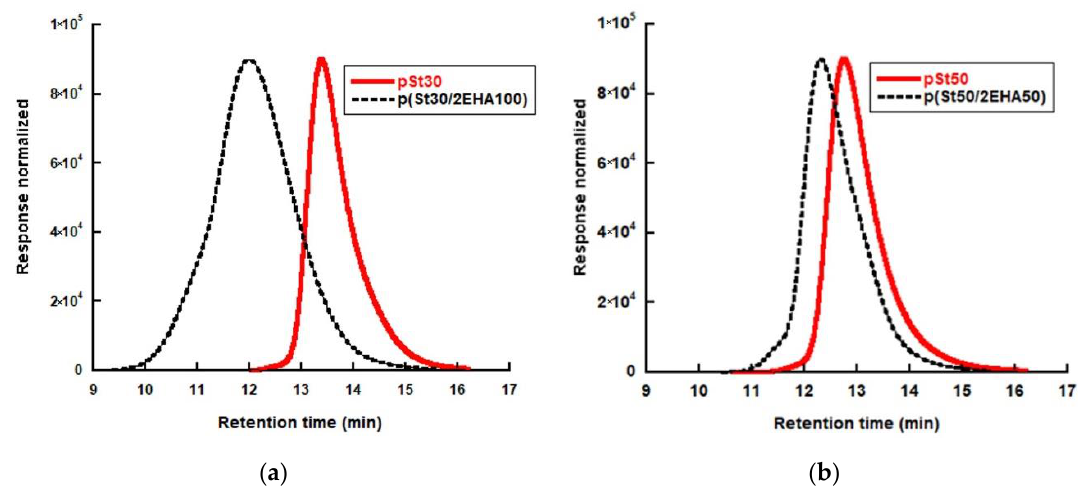
Figure 4. Molecular weight distribution (MWD) of the initial pSt homopolymer and the final block copolymers for ( a ) p(St30/2EHA100) and ( b ) p(St50/2EHA50) as measured by RI detection in GPC.